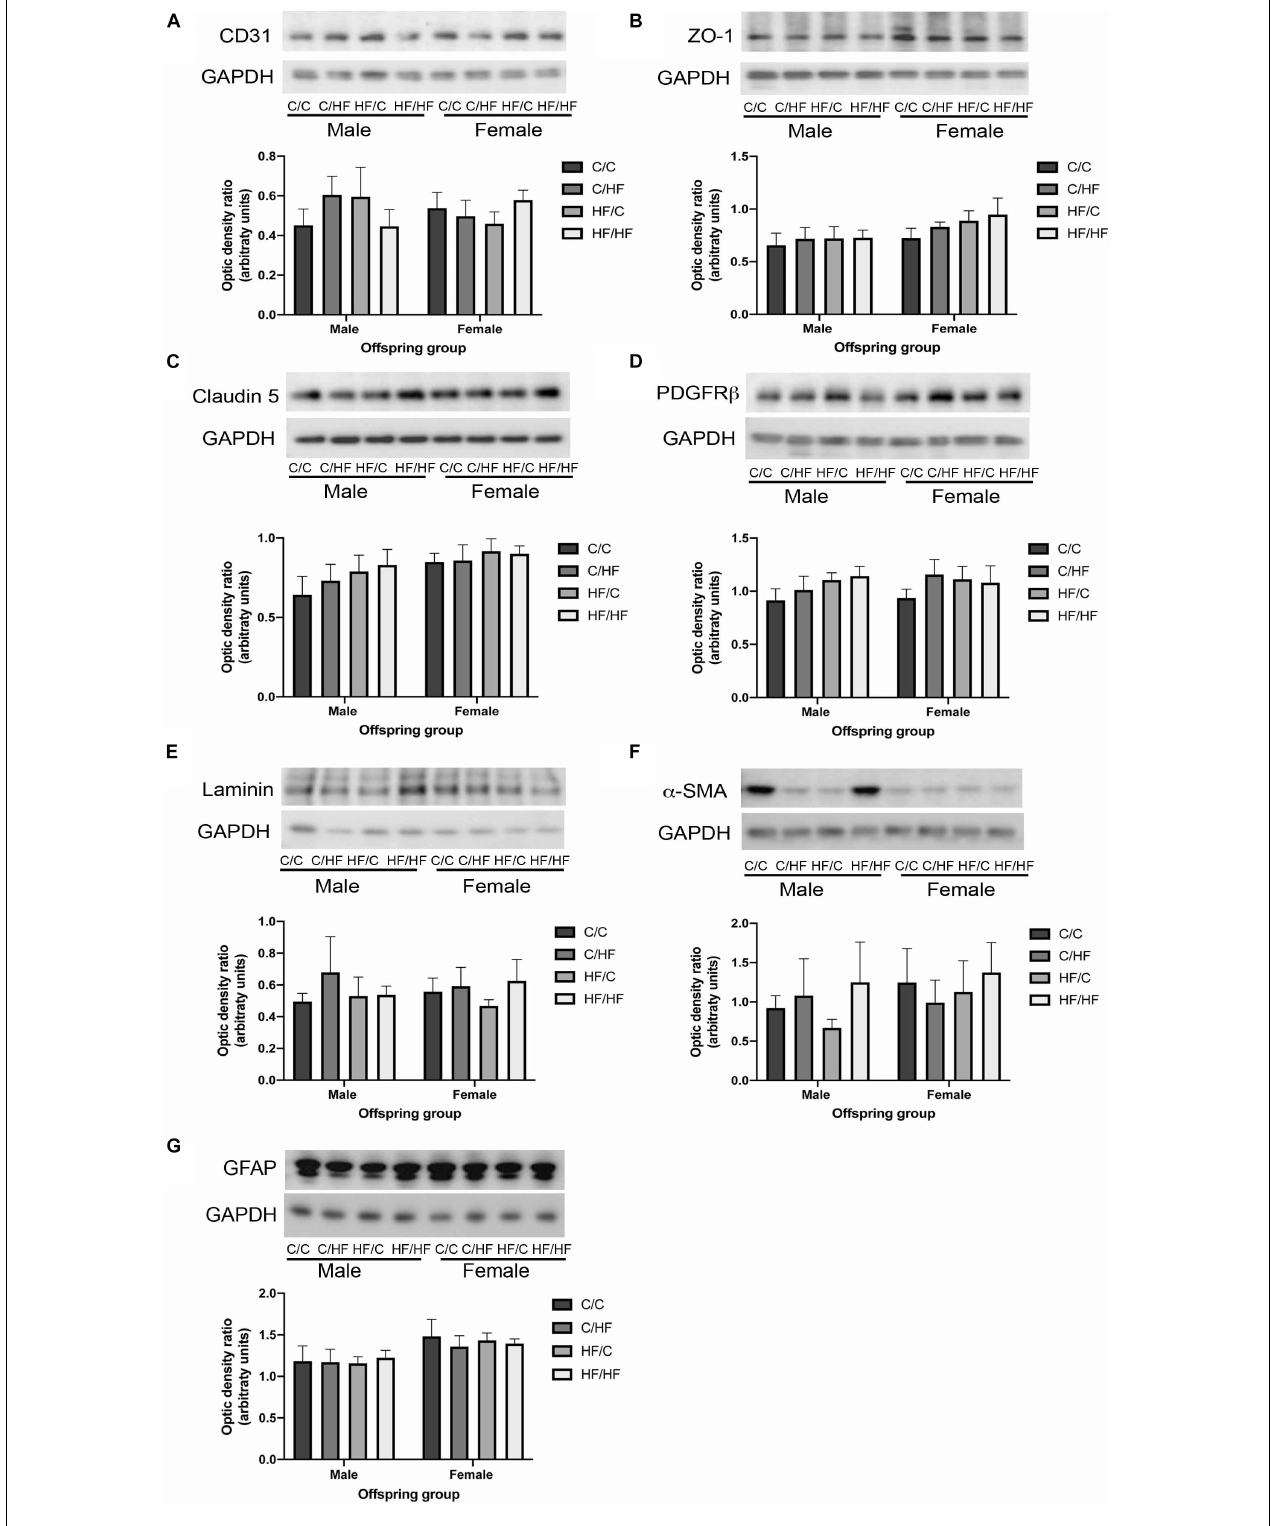
FIGURE 2 | Expression of neurovascular unit components in aged offspring. (A–G) Hippocampal homogenates from 16-month old male and female C/C, C/HF, HF/C and HF/HF mice were assessed by Western blot to determine the expression of CD31 (A) , zona occludens-1 (ZO-1, B ), claudin 5 (C) , platelet-derived growth factor receptor- β (PDGFR β , D ), laminin (E) , α -smooth muscle actin ( α -SMA, F ) and glial fibrillary acidic protein (GFAP, G ). Data represent mean ± SEM.